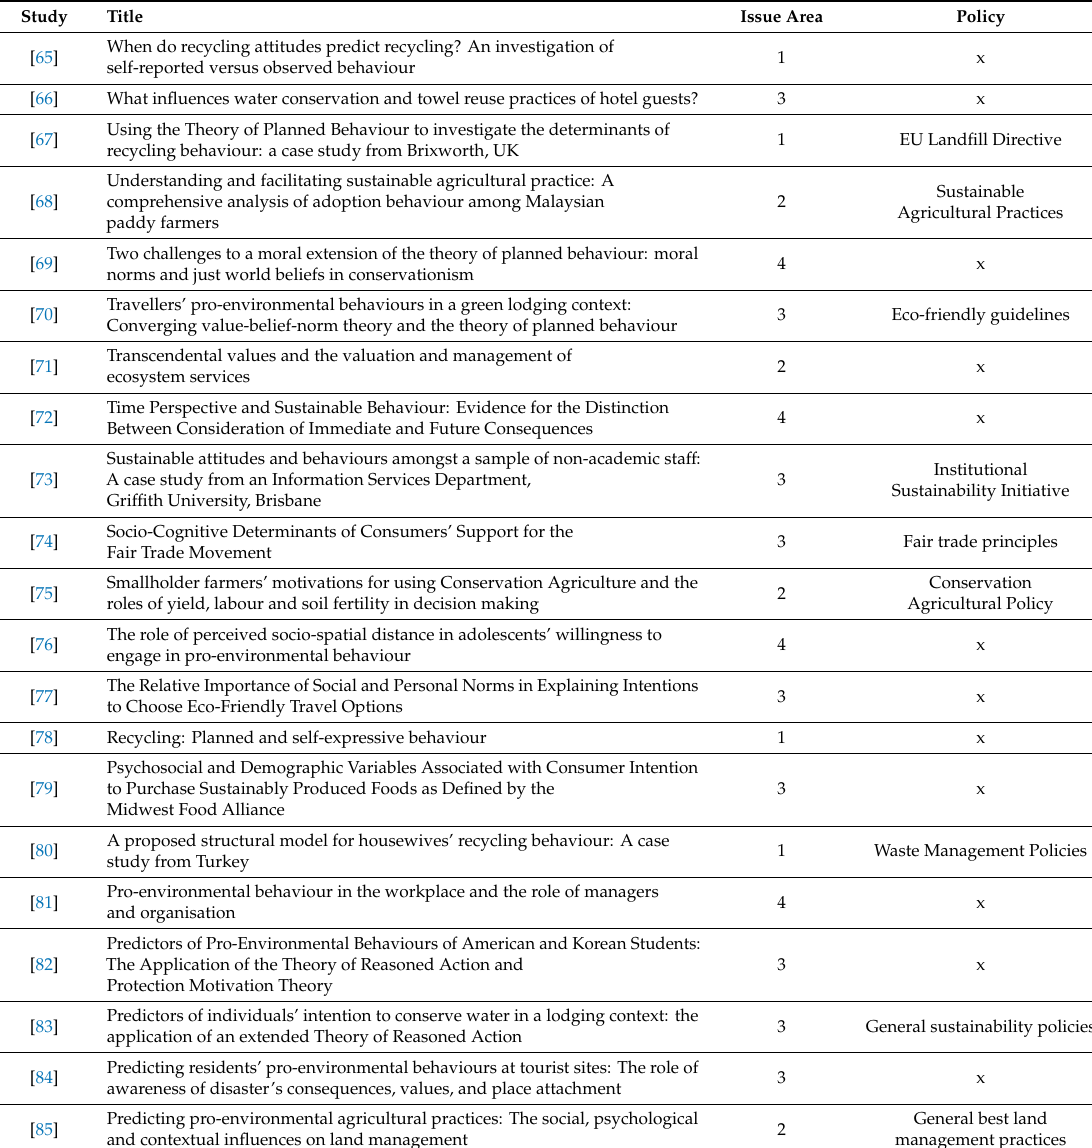
Table A1. Final Papers Included in the